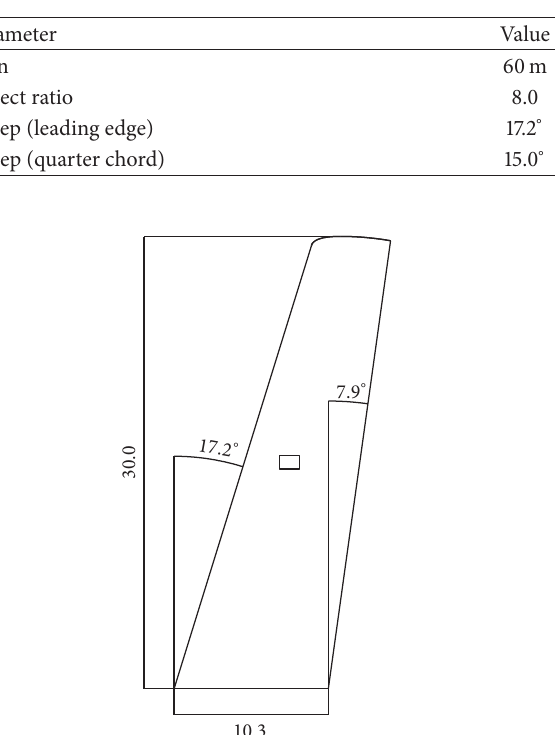
Table 1: Geometric quantities for DPW-W1 wing.